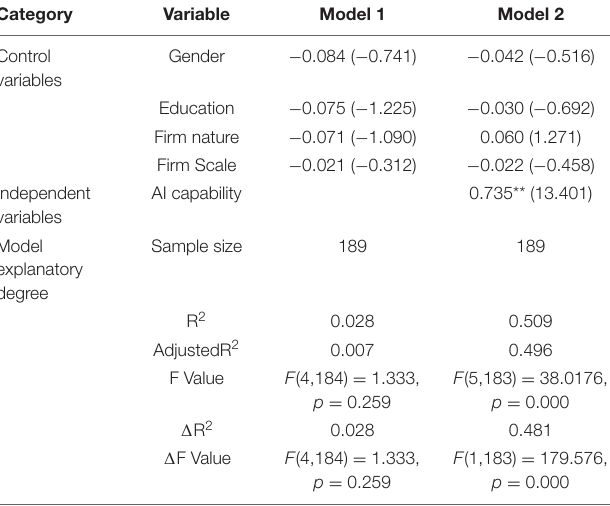
TABLE 6 | Multilevel regression test results (Explanatory variable: Knowledge